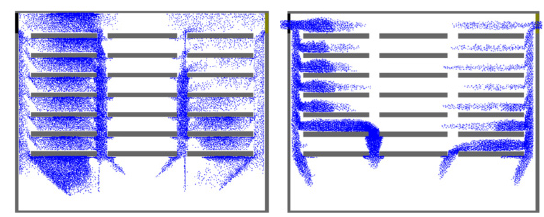
Fig. 24 Snapshots for the two-exit environment at frame 2000. Left: dynamic method from Ref. [48]; k s = 0 . 008, k r = 0 . 00015, and k d = 0 . 00025. Agents tend to move along the aisle regions as their total attractive value is higher than for neighboring regions. Right: our method.